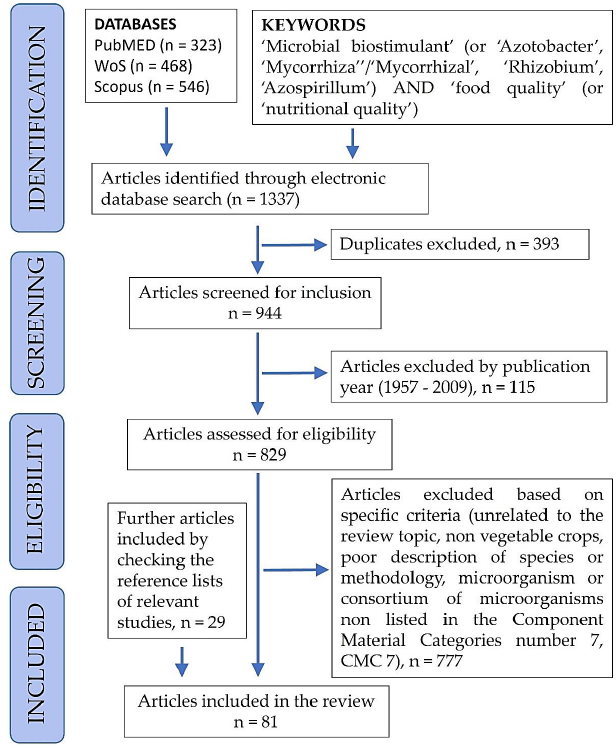
Figure 1. Representation of the PRISMA flow diagram with inclusion and exclusion criteria and corresponding results from the literature search, used to select articles for the review study [29].